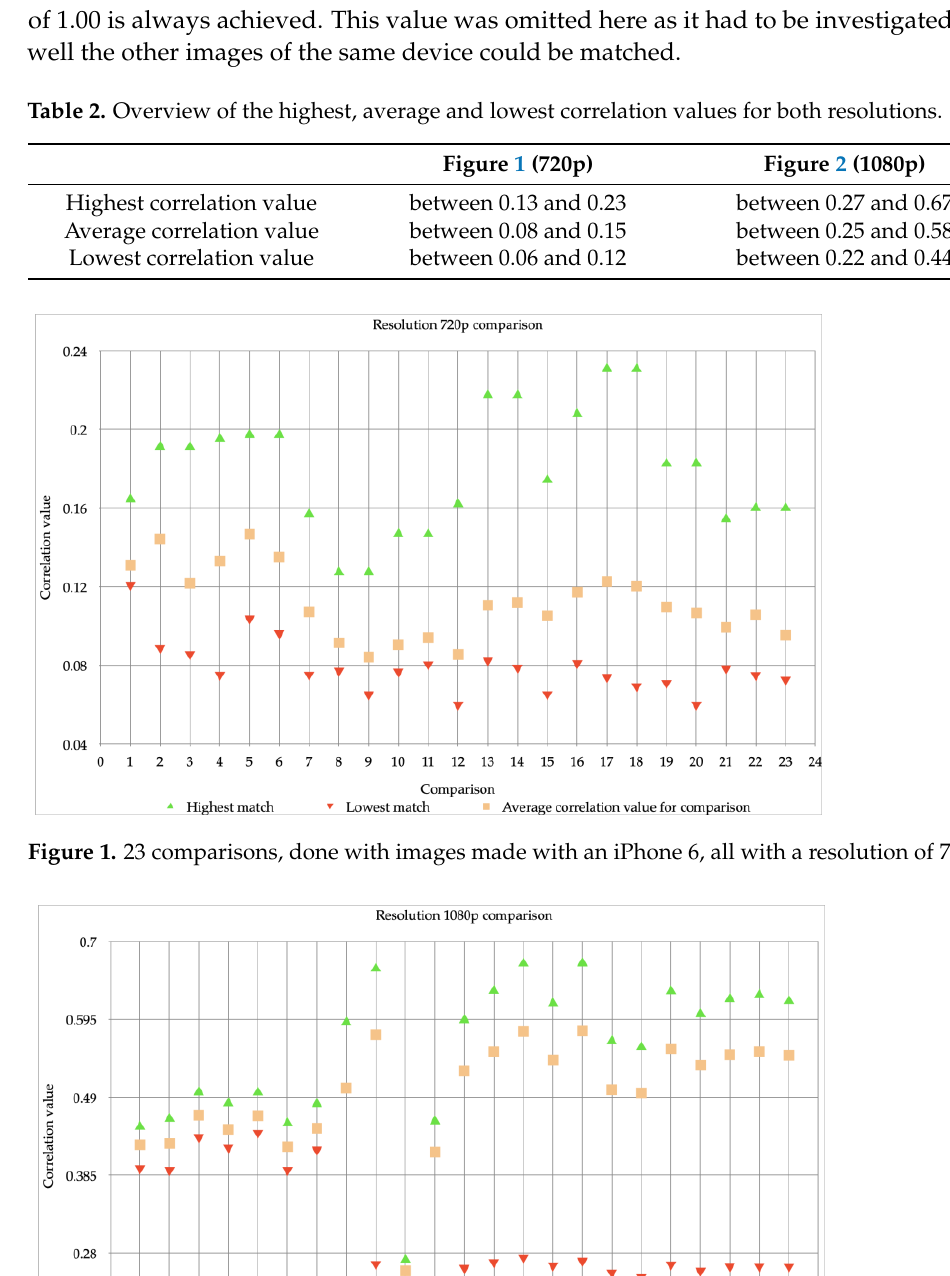
Figure 2. 23 comparisons, done with images made with an iPhone 6, all with a resolution of 1080p.